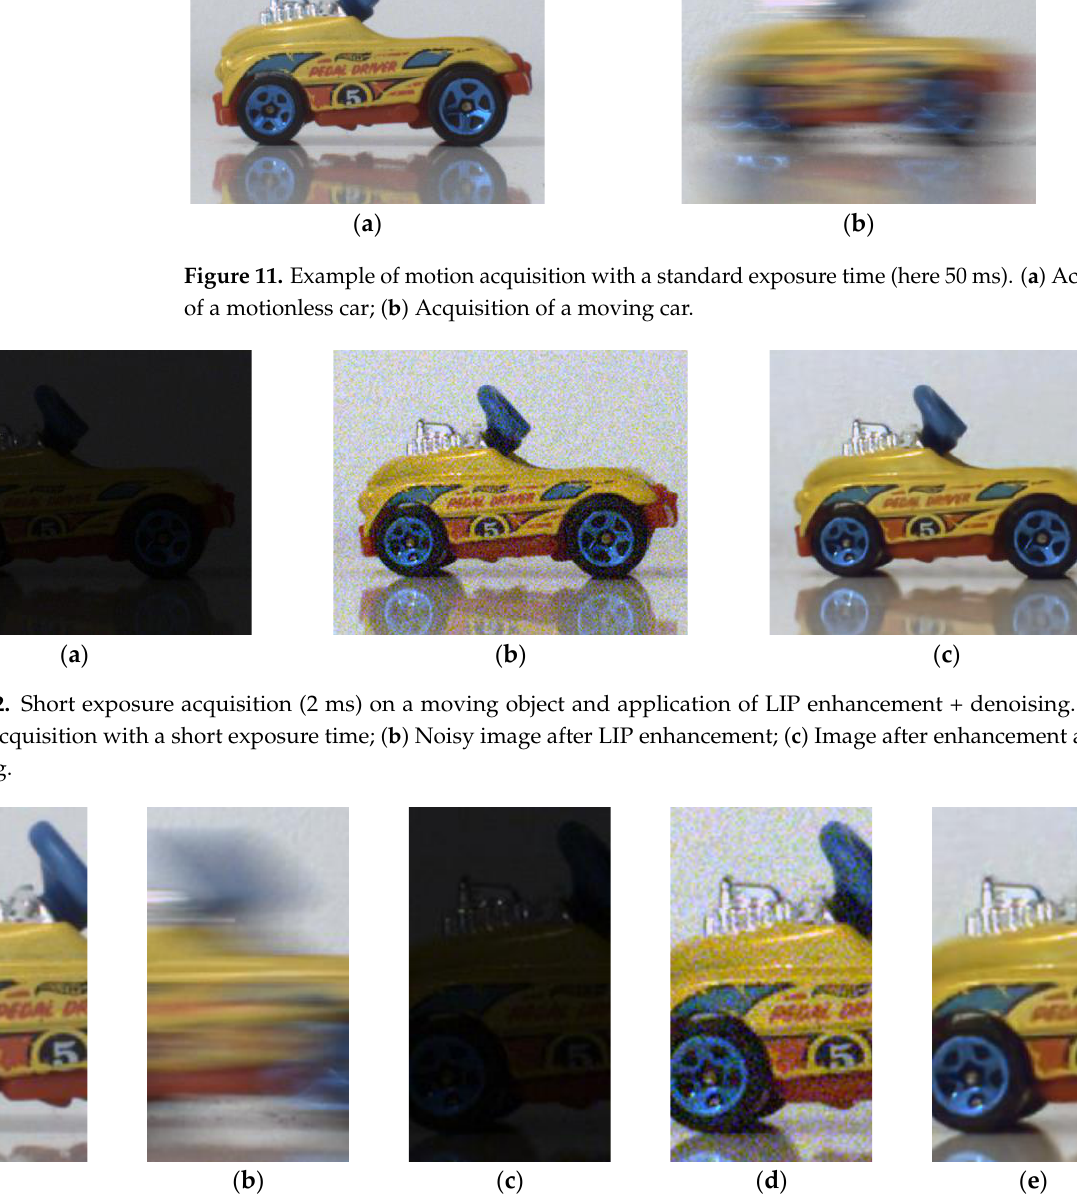
Figure 13. Zoom on figures 11 and 12. ( a ) Acquisition of a motionless car at 50 ms; ( b ) Acquisition of a moving car at 50 ms; ( c ) Motion acquisition with a short exposure time (2 ms); ( d ) Noisy image after LIP enhancement; ( e ) Image after enhancement and denoising.